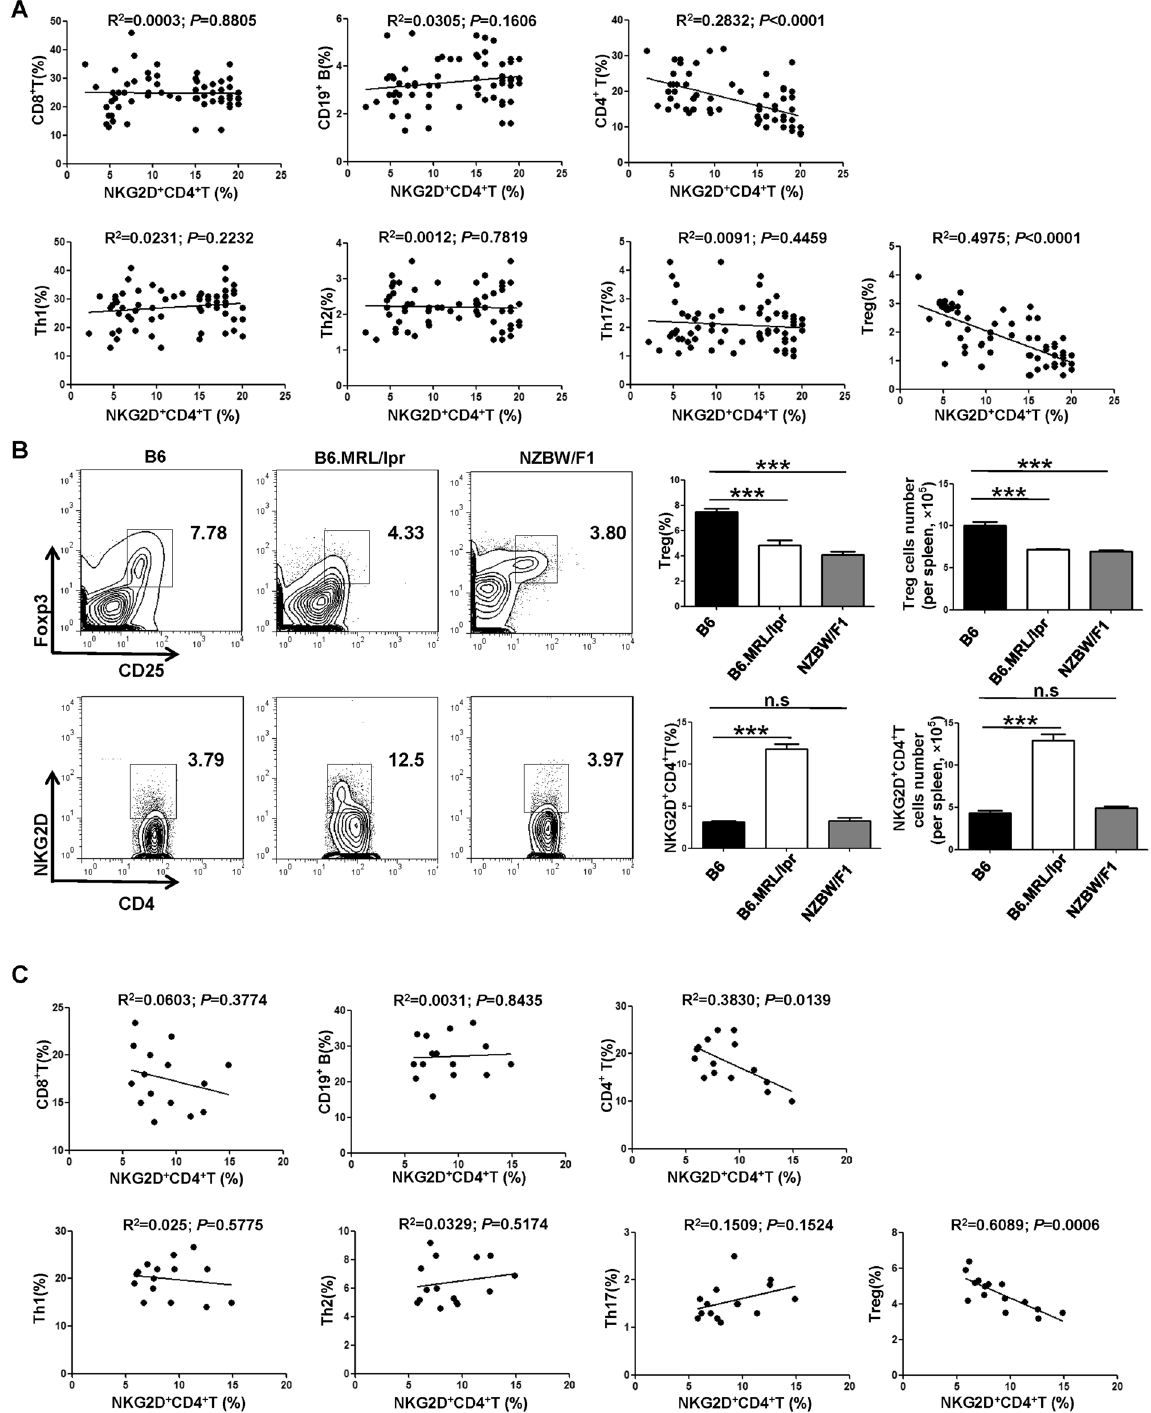
Figure 2. Inverse correlation between the frequencies of NKG2D-expressing CD4 + T cells and Treg cells in both SLE patients and MRL/lpr mice. ( A ) Correlation analysis of the frequencies of NKG2D + CD4 + T cells and T cell subsets and B cells in SLE patients (n = 66). The correlation coefficient and P value are indicated. ( B ) Representative and statistical data of the frequency or cell numbers of Tregs and NKG2D + CD4 + T cells in splenocytes from B6.MRL/lpr mice, NZBW/F1 mice and C57L/B6 control mice (B6). Data represent three independent experiments with 3–5 mice each. Numbers represent percentages. Horizontal lines with bars show the mean ± SD. *** P < 0.001. ( C ) Correlation analysis of the frequencies of NKG2D + CD4 + T cells and T cell subsets and B cells in B6.MRL/lpr mice. The correlation coefficient and P value are